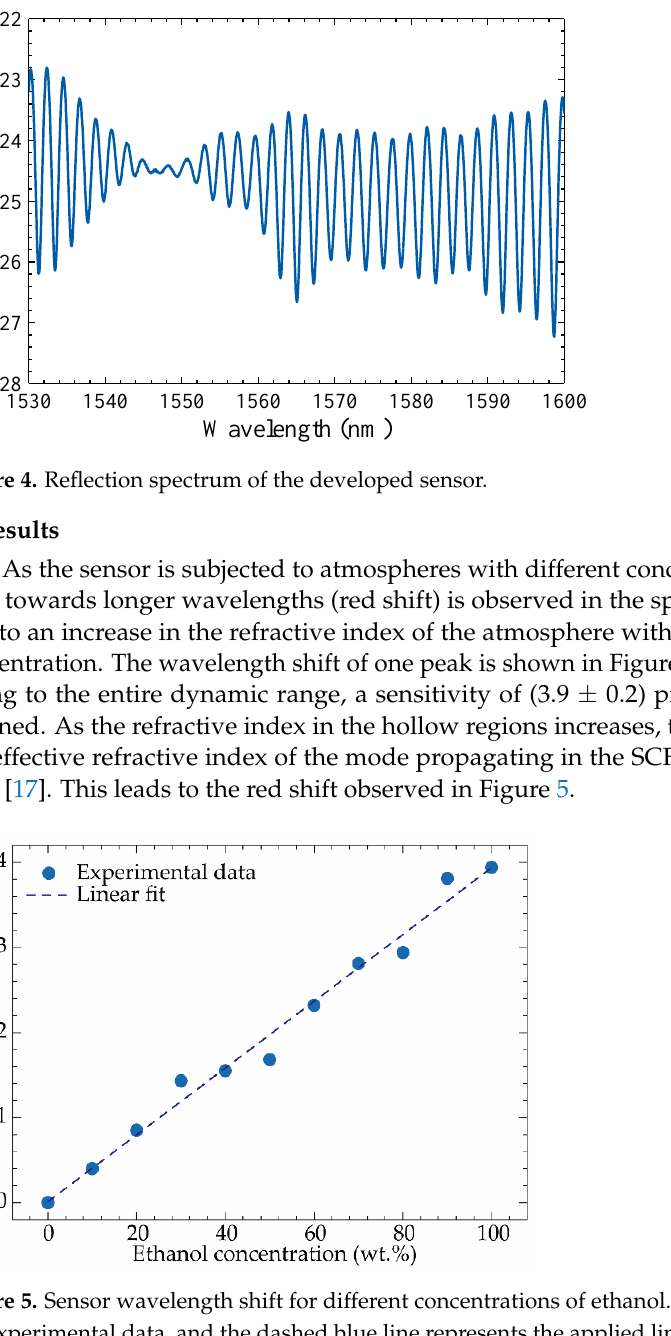
Figure 6. Sensor’s wavelength stability over a period of 90 min, for the two gaseous ethanol concentrations of 20 wt.% (red) and 30 wt.% (blue). The red and blue shadowed zones represent the data standard deviation for each ethanol concentration step, denoted by σ λ . The wavelength mean values of 1564.118 and 1564.175 nm were obtained for the 20 wt.% and 30 wt.% steps, respectively, and a resolution value (δ %m ) of 0.7 wt.% was attained through the following equation. δ %m = 2 σ λ Δ(wt.%)/Δ λ , (2) where σ λ is the maximum wavelength standard deviation, and Δ(wt.%) and Δ λ are the ethanol concentration and wavelength differences between each step, respectively. To assess the sensor cross-sensitivity with temperature variations, a thermal characterization was conducted using a custom thermal chamber based on a Peltier module. A total of 13 temperature steps were used in the thermal characterization, with the temperature ranging between 25 and 87 °C and a stabilization time of 10 min. The experimental data, and correspondent linear fit, are depicted in Figure 7.